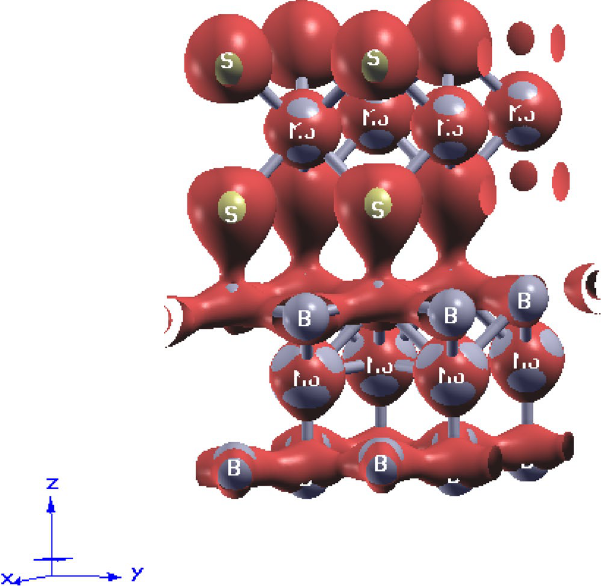
Figure 8. Isosurface results of MoS 2 / MoB 2 HS showing the interfacial charge transfer between B-2p and S-3p orbitals.